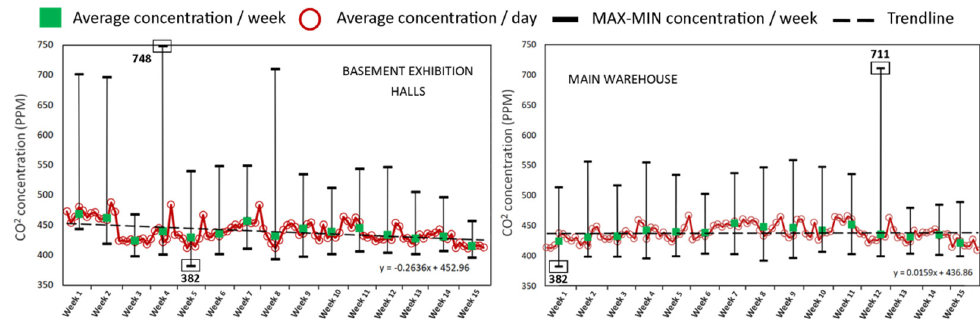
Figure 6. Graphical representation of CO 2 amount variations per week